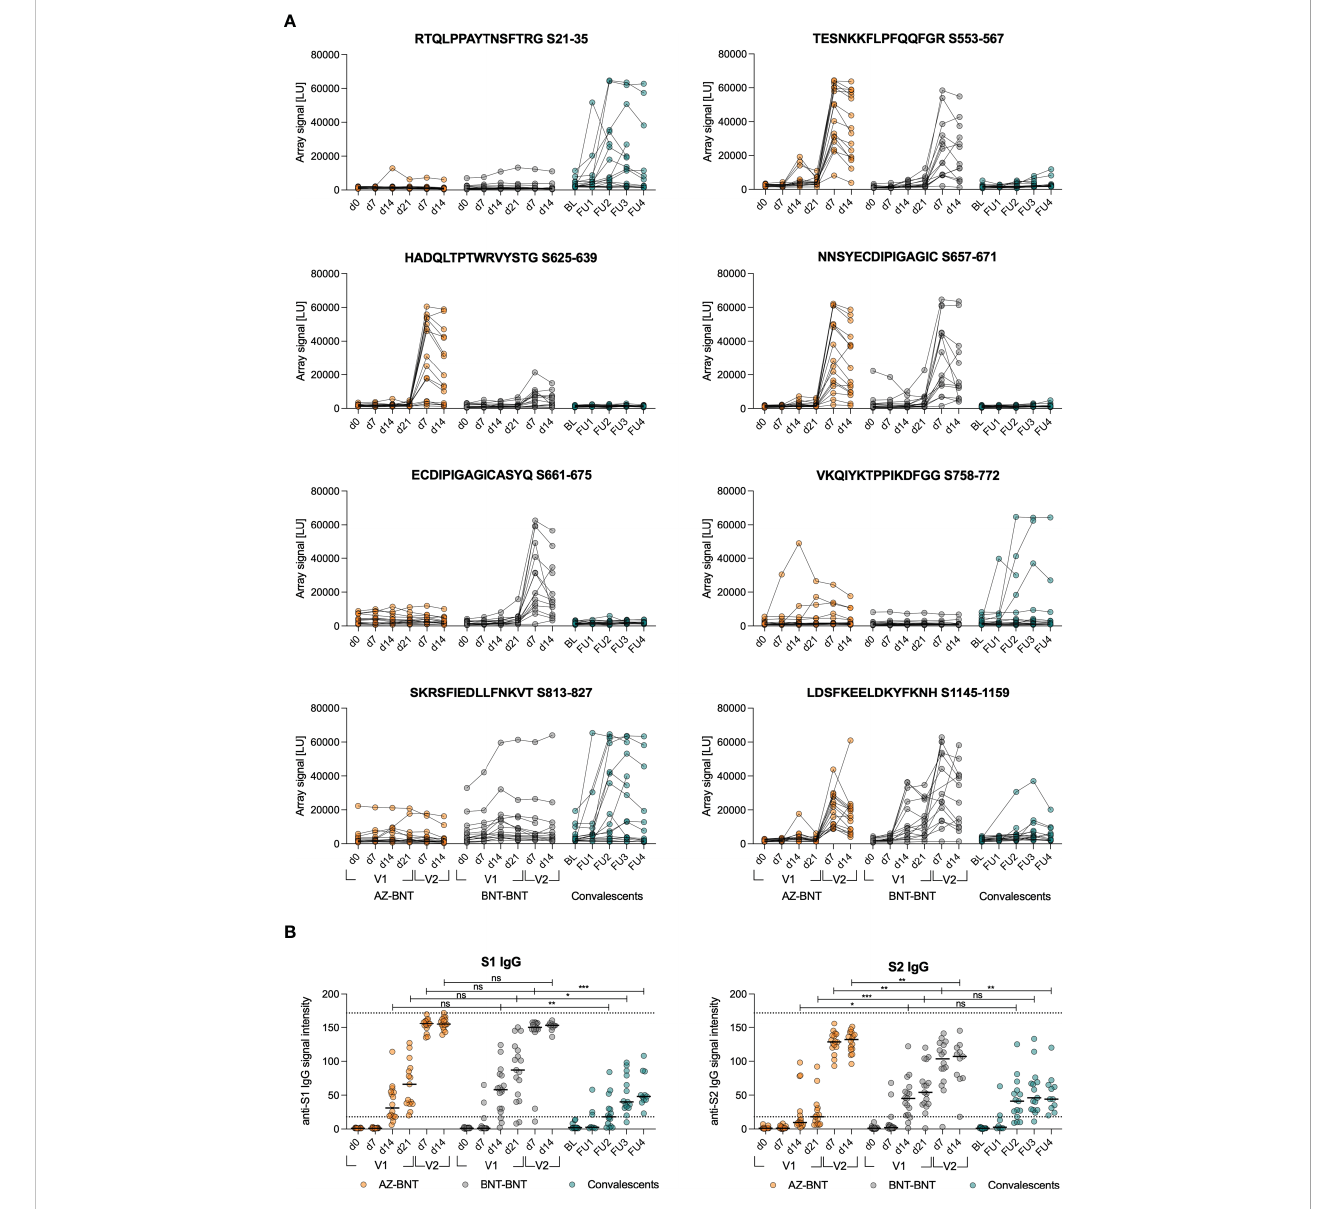
FIGURE 4 Cross-reactive humoral responses are not effectively induced by AZ primary vaccination. (A) Signal from sample incubation on peptide microarrays for selected peptides following AZ-BNT (n=16), BNT-BNT (n=15) vaccination or infection (convalescents (CS), n=17). (B) Levels of anti-S1 or anti-S2 IgG binding antibody intensity units in indicated cohorts. Dotted lines indicate lower cut-off at 18 for values classi fi ed as positive and upper cut-off at 172. BL=baseline, FU=follow-up. ns=not signi fi cant, *P < 0.05, **P < 0.01, ***P < 0.001. Mann-Whitney test. Black line indicates the